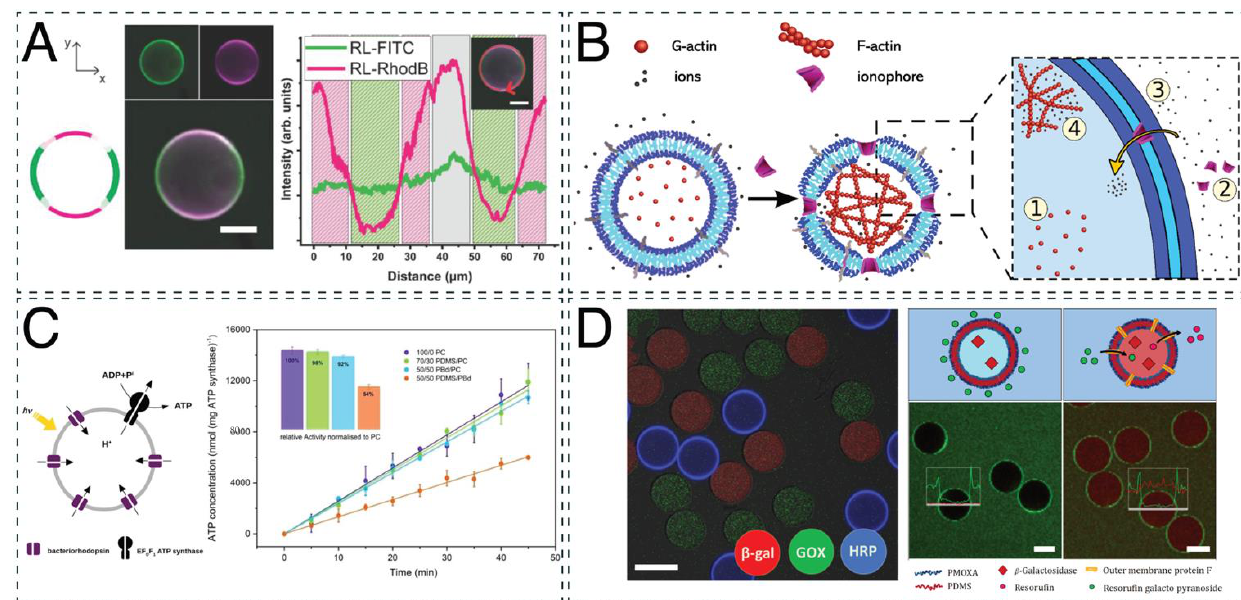
Figure 4. Applications of polymeric compartments to mimic cellular aspects. ( A ) Cross-sectional micrograph of DPPC-mPEG- b -PCL GUVs stained via fluorescein isothiocyanate (FITC, on mPEG- b -PCL, green) and Liss Rhod PE (in DPPC, red). Adapted with permission from [73].